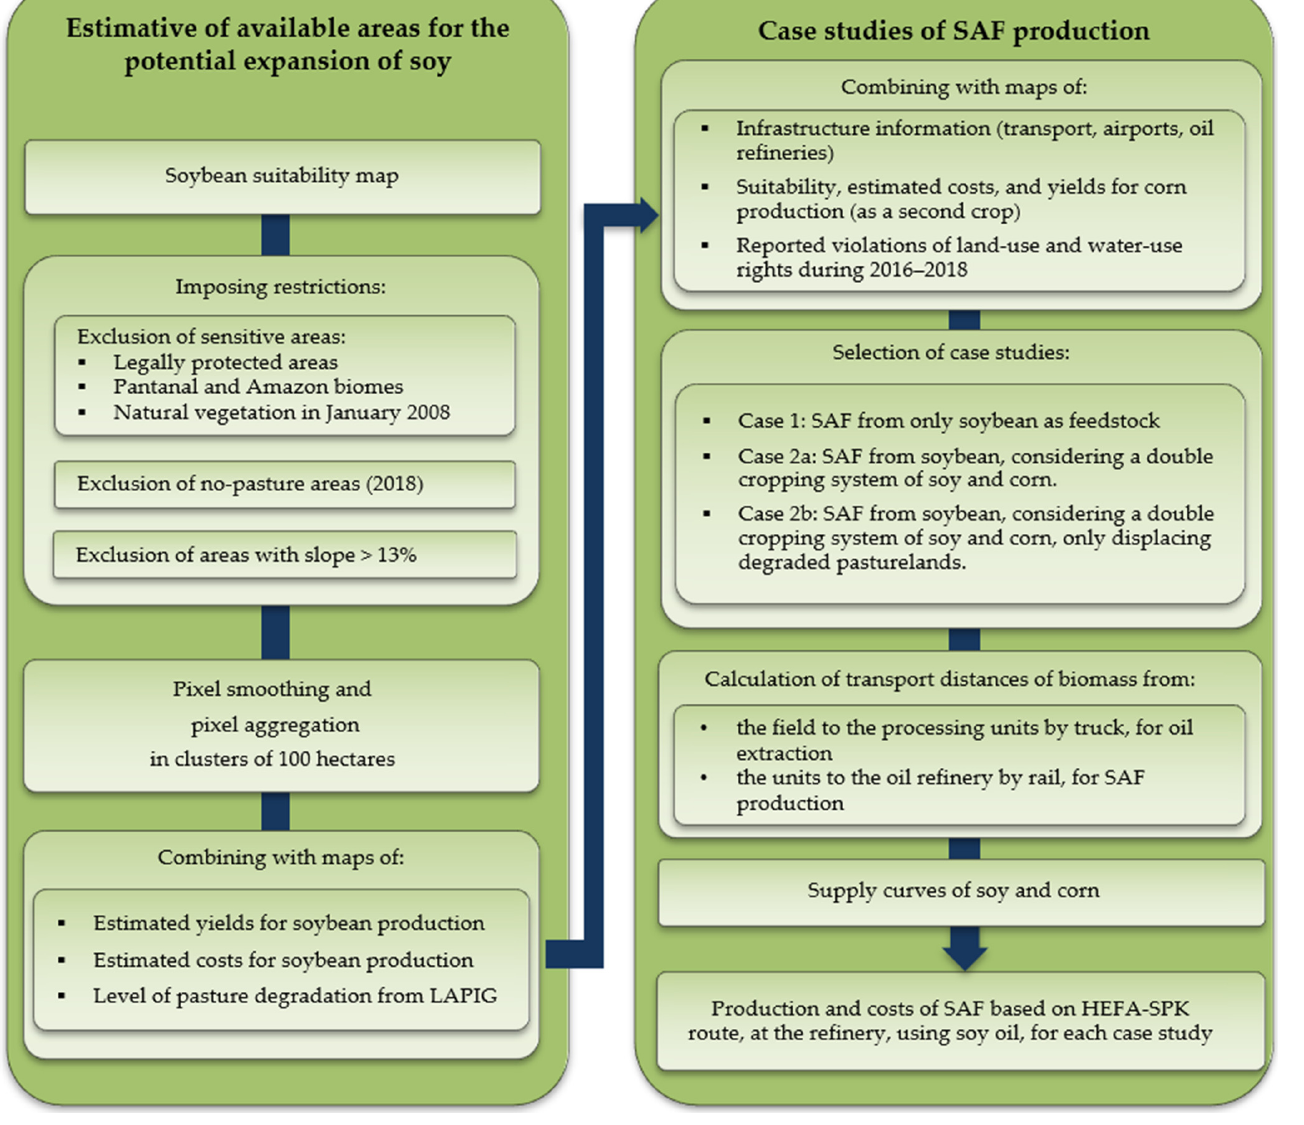
Figure 1. Framework used to estimate the available land for soy expansion in the 12 Brazilian states, and to define the case studies. and to define the case